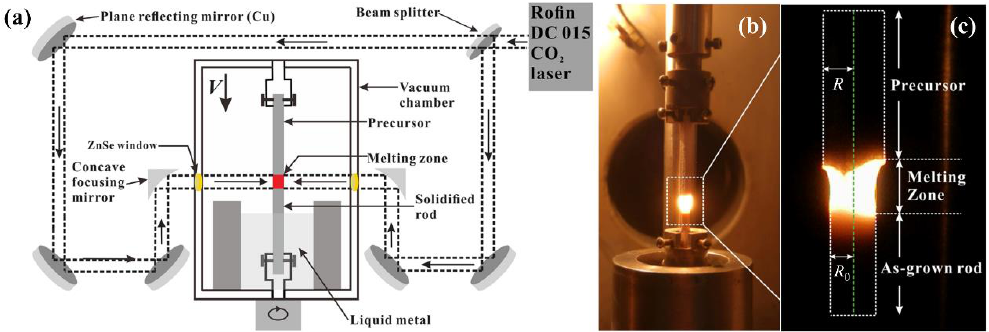
Figure 3. Diagrammatic view of the laser floating-zone melting apparatus ( a ); photograph of the procedure of an Al 2 O 3 -based, directionally solidified eutectic ceramic specimen ( b ); and principle of the capillary stable-crystal-growth condition ( c ). Reproduced with permission from Reference [53], Copyright © 2019 Elsevier Inc., and Reference [90], Copyright © 2021, Elsevier.